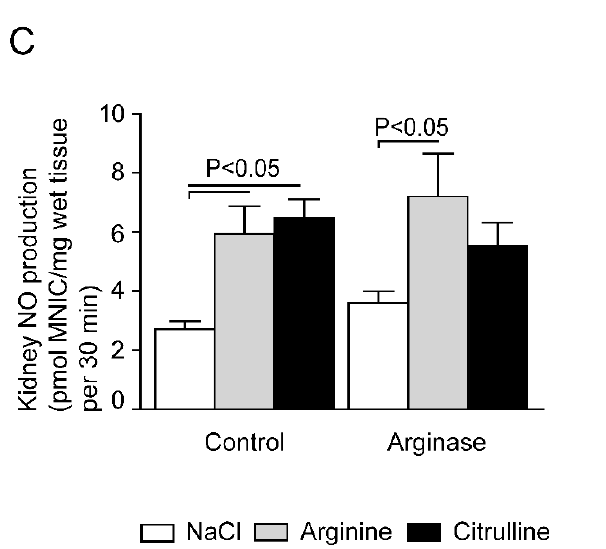
Figure 8. Tissue NO production in control and arginase-treated animals with L -arginine or L -citrulline supplementation. ( A ) The expected arginase-induced decrease in jejunal NO production, determined as pmol mono-nitrosyl iron complex (MNIC)/mg wet tissue, was